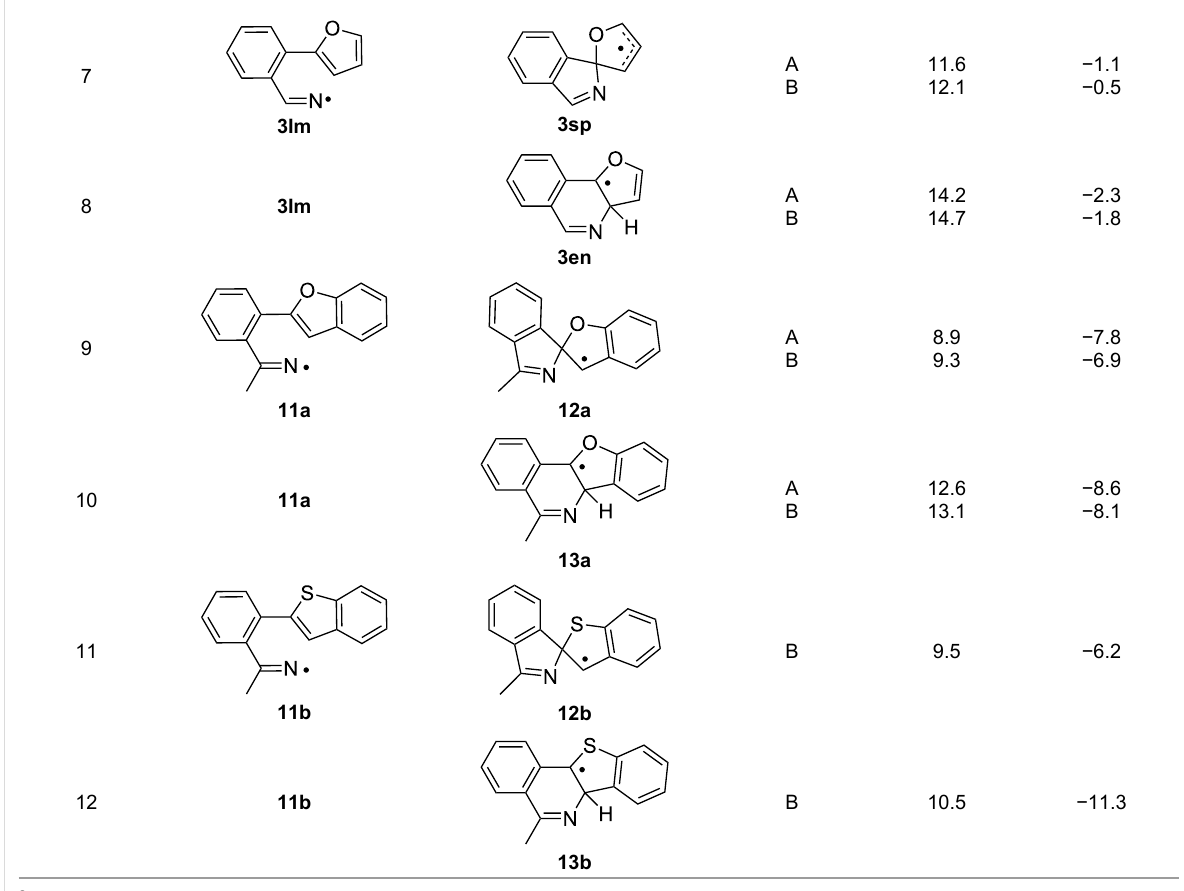
Table 4: DFT computed activation energies ( Δ E ‡ 298 ) and reaction enthalpies ( Δ H 298 ) in kcal mol − 1 for aromatic iminyl radicals.